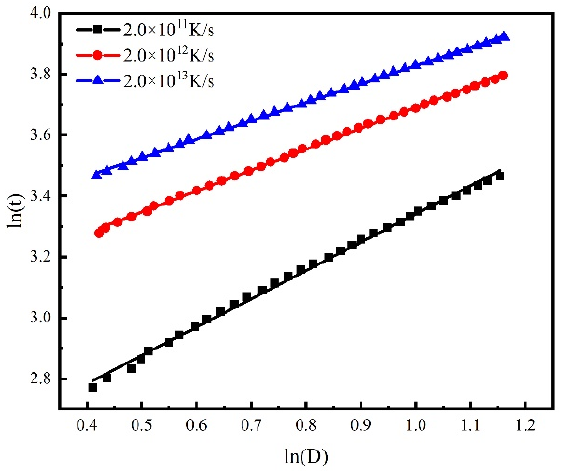
Figure 8. Grain growth kinetics curve of the isothermal solidification process with different cooling rates.